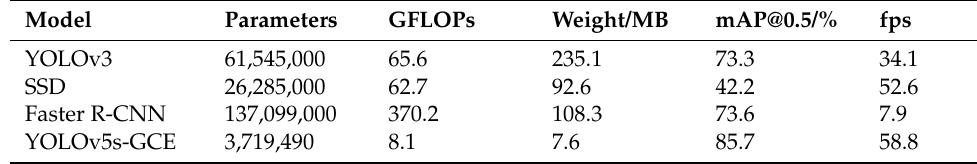
Table 2. Performance comparison of different algorithms.